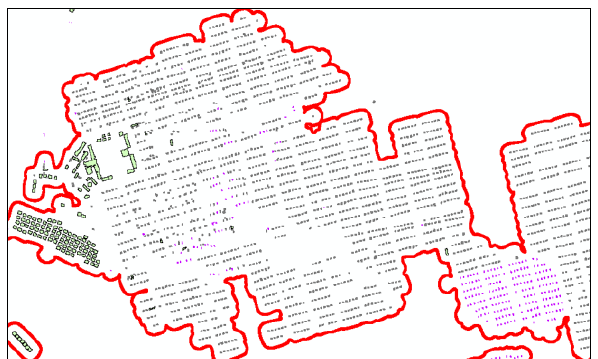
Subset of the results obtained from the OBIA approach, including the automatically derived camp extent (based on dwelling density